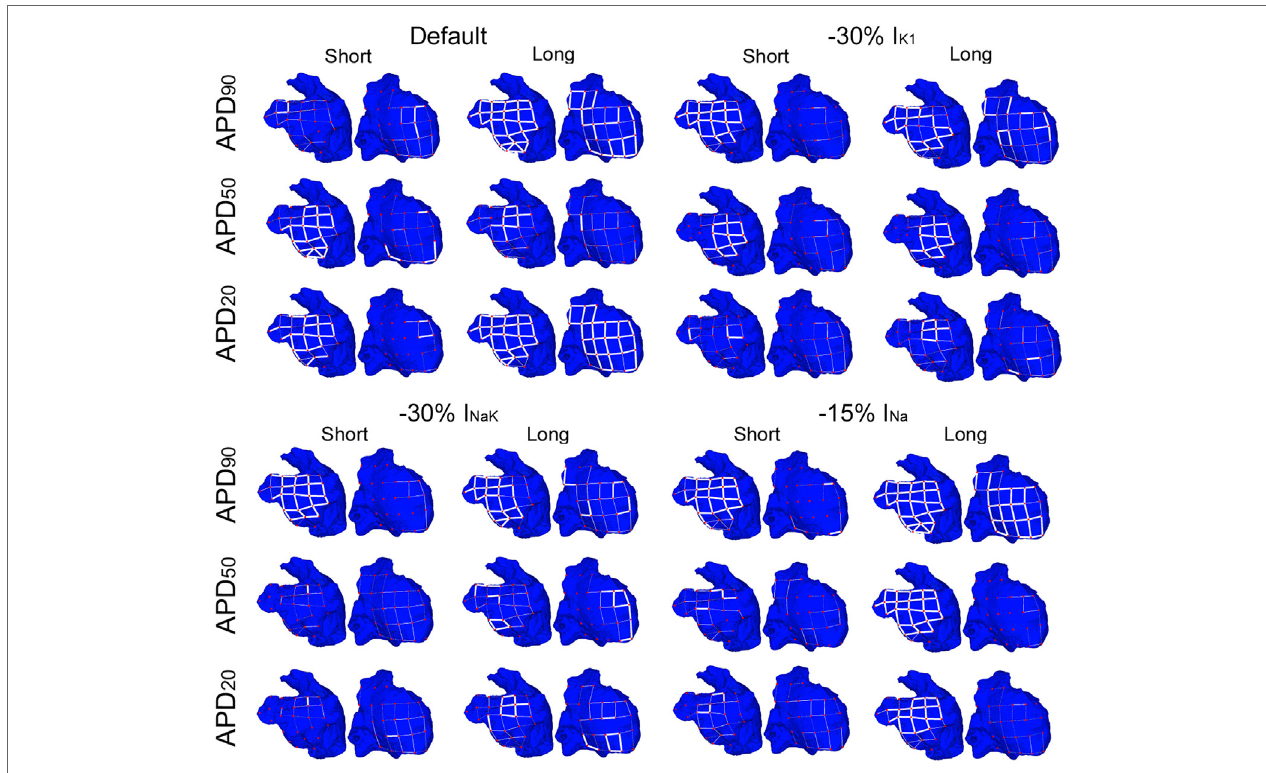
FigUre 7 | Modulation of coupling index (cP) of reentry in atrial fibrillation by intersubject variability in action potential phenotype in response to ion channel block . Dorsal views of the left atrium (left) and right atrium (right) are shown. CP between electrogram in adjacent electrodes (thick white lines represent CP > 0.9, thin solid lines represent 0.75 ≤ CP < 0.9, and soft gray lines represent 0.6 ≤ CP < 0.75. CP < 0.6 is represented by absence of lines) for short and long APD 90 , APD 50 , and APD 20 subpopulations of models before (default) and after 30% I K1 inhibition, 30% I NaK inhibition, and 15% I Na inhibition,